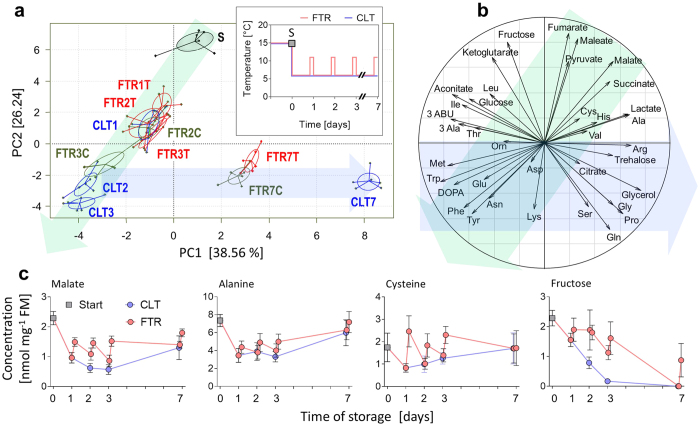
Cold-induced changes in metabolite composition.(a) The plot of PC1 and PC2 derived from principal component analysis shows clustering of treatments according to metabolite global composition analysed in quiescent larvae of Drosophila melanogaster stored at CLT 6 °C and FTR 6 °C/11 °C for 7 days. The inset schematically depicts CLT and FTR thermal regimes (for more information, see Fig. S1a). Six replicates of each treatment are linked to a common centroid by line segments; the ovals represent 95% confidence intervals around the centroid. (b) The projection of individual metabolites on the correlation circle helps to identify major drivers in cold-induced alteration of metabolite composition during the first 3 days (green arrow) and later (blue arrow). (c) examples of cold-induced concentration changes in four metabolites. For complete metabolite dataset, see Table S1.